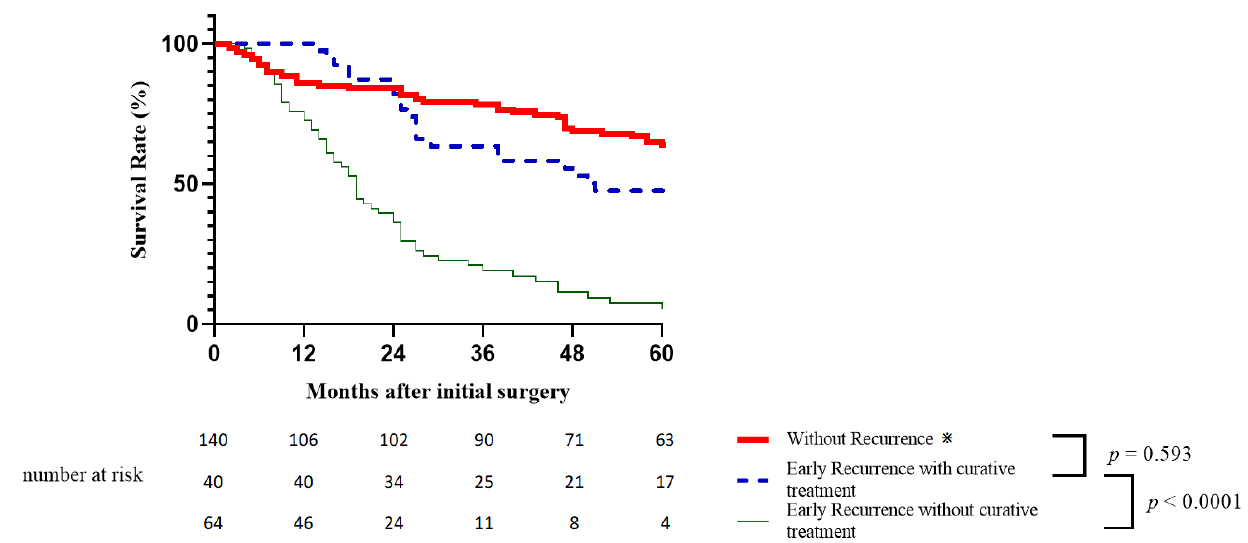
Figure 3. Overall survival according to early recurrence stratified by treatment. ( ⋇ after excluding patients who died within 90 postoperative days in this group).